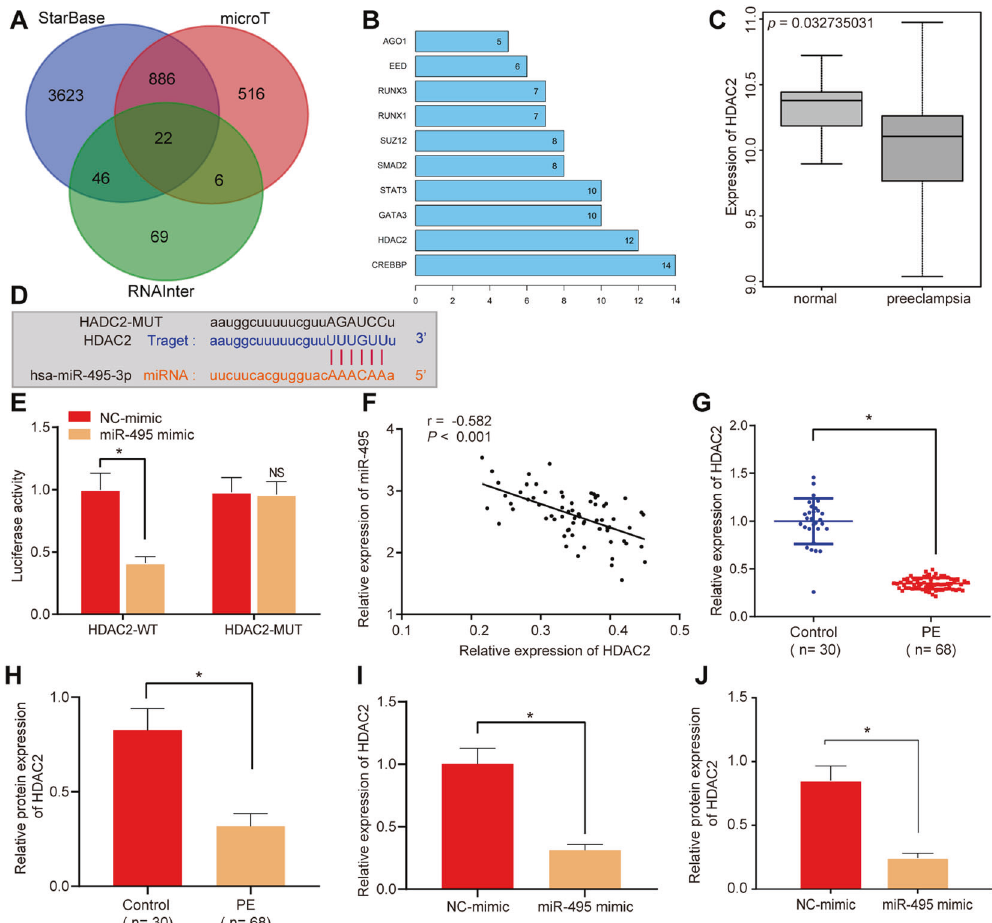
interaction of target genes, Y axis shows target genes. C HDAC2 expression in microarray GSE48424. X axis represents the sample types; Y axis represents the expression of HDAC2. D Binding site between HDAC2 and miR-495 predicted by Starbase. E Dual-luciferase reporter gene-assay veri fi cation on the relationship between HDAC2 and miR-495. F Pearson correlation analysis of HDAC2 and miR-495 through Pearson ’ s correlation coef fi cient. G RT-qPCR detection on HDAC2 expression in umbilical cord tissues of different groups (control n = 30, PE n = 68). H Western blot analysis on HDAC2 expression in umbilical cord tissues of different groups (control n = 30, PE n = 68). I RT-qPCR detection on HDAC2 expression in HTR8/SVneo cells 48 h after transfection. J Western blot analysis on HDAC2 expression in HTR8/SVneo cells 48 h after transfection. * p < 0.05 vs. control or NC mimic. The quantitative data were presented as mean ± standard deviation. Difference between two groups was analyzed by paired t- test. Cell experiments were repeated 3